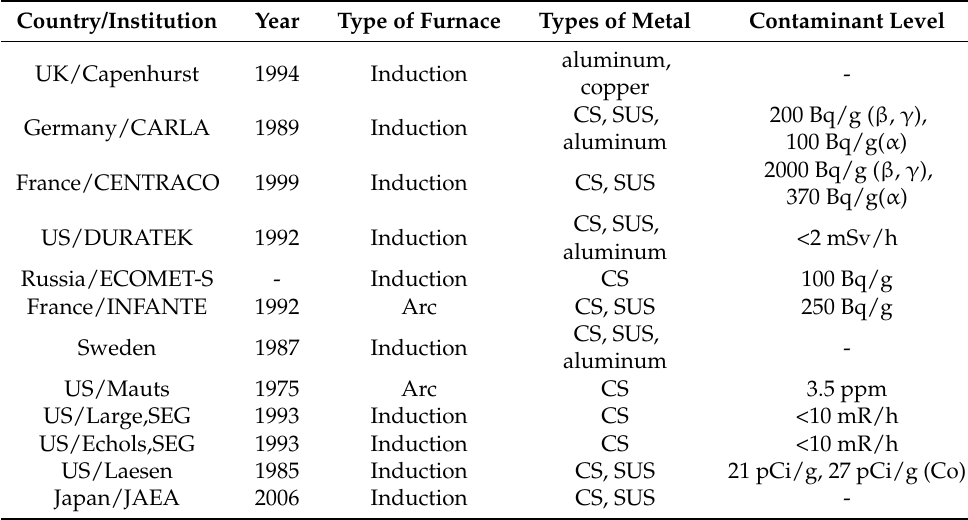
Table 1. Examples of melting decontamination studies